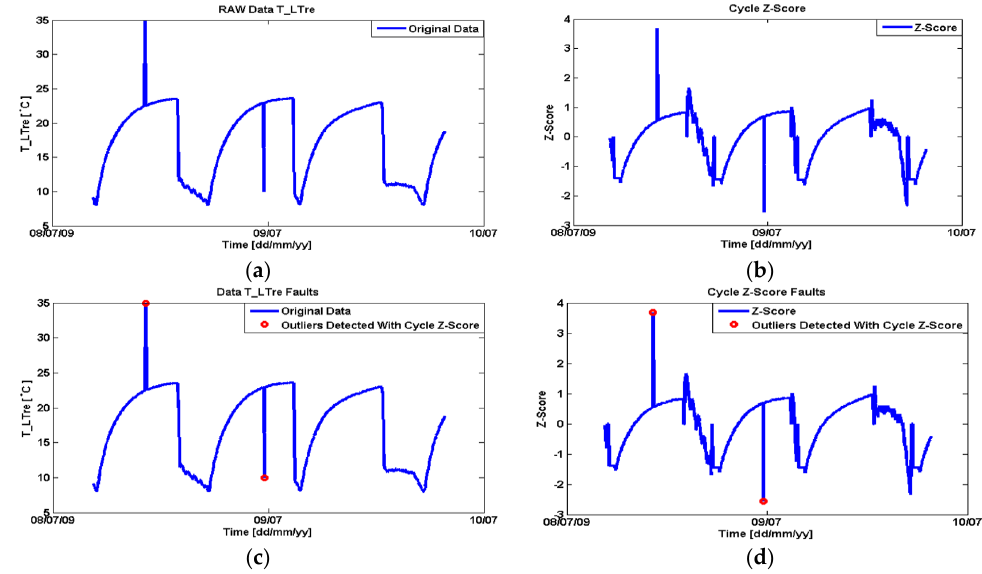
Figure 8. Outlier detection using z ‐ scores: ( a ) Raw data of T_LTre; ( b ) cycle based z ‐ score representation of the raw data; ( c ) faults detected in the raw data; ( d ) faults detected in the corresponding z ‐ score representation.